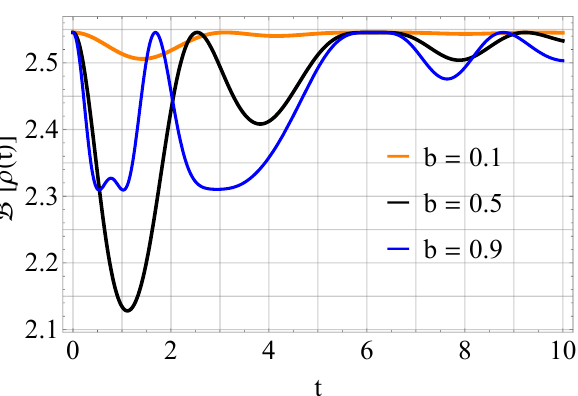
Figure 6. B [ ρ ( t )] for three values of b . The other parameters are r = 0.9, ω = π /6, and ∆ = 0.5.